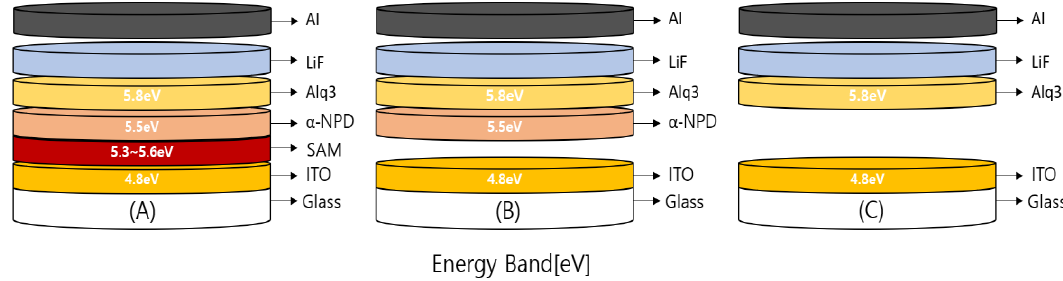
Figure 1. Energy band schematic. Table 1. OLED layer thickness.